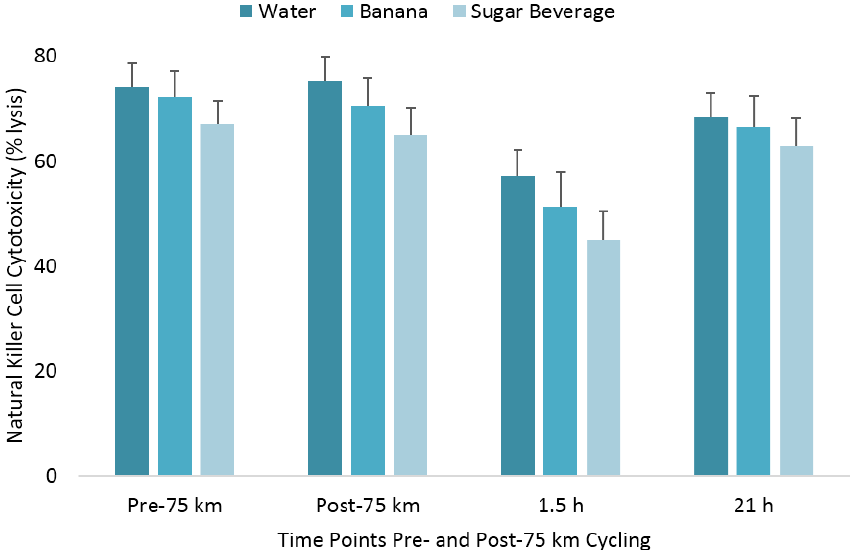
Figure 3. Change in natural killer cell cytotoxicity following 75 km cycling in n = 20 cyclists (immediately, 1.5 h, and 21 h post-exercise). The changes from pre-exercise in the banana and sugar beverage trials did not differ from the water trial. Vertical lines represent the standard errors. Time effect, p = 0.014; time × trial effect, p < 0.001.